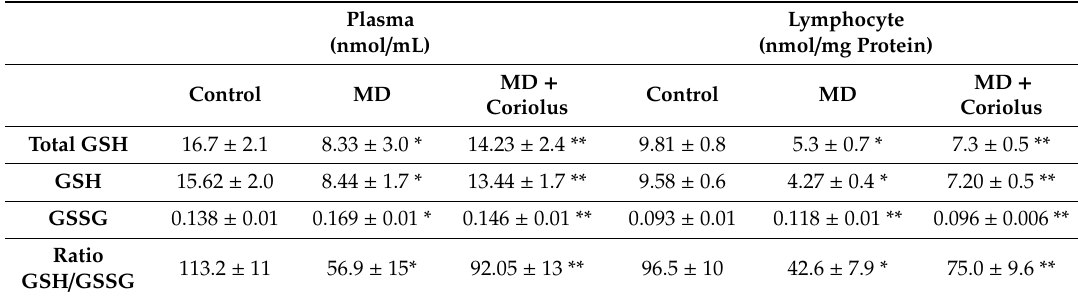
Table 4. Plasma and lymphocyte content of total, reduced (GSH) and oxidized (GSSG) glutathione in control and MD patients treated with